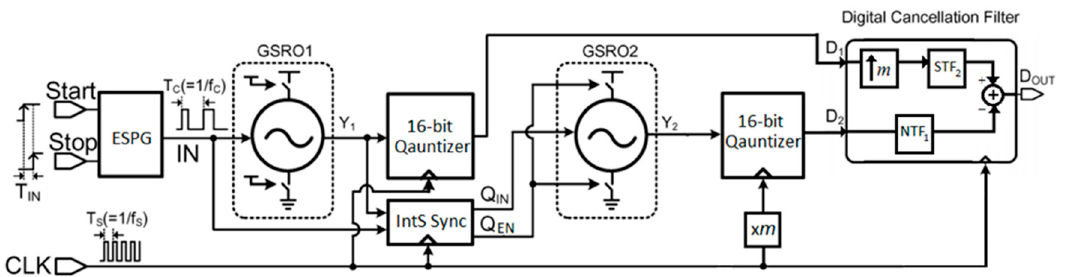
Figure 5. Block diagram of the proposed 1-1 MASH multirate TDC.